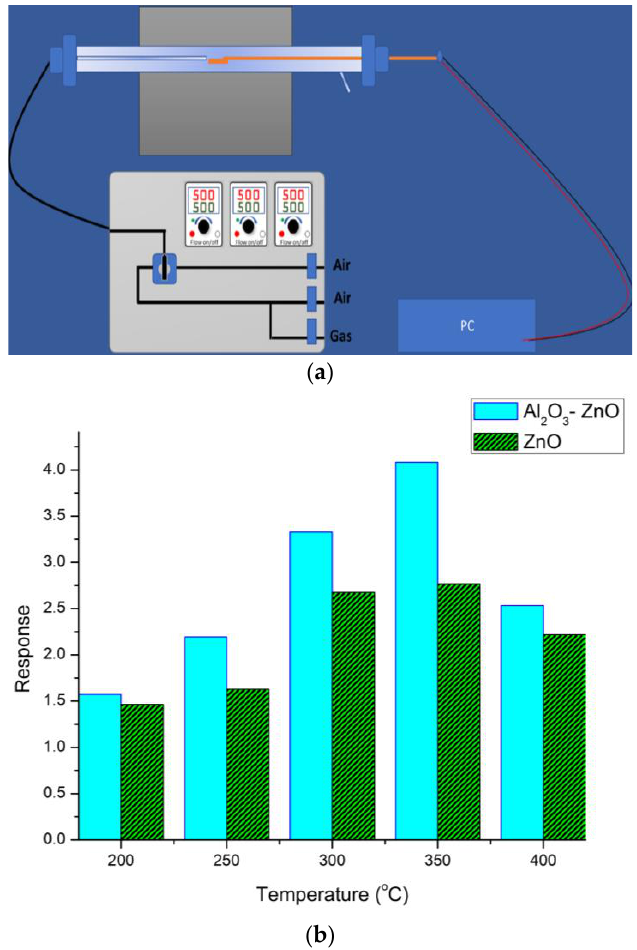
Figure 6. ( a ) Schematic diagram of the gas sensing measurement set-up. ( b ). Responses of Al 2 O 3 -ZnO nanostructures grown on Au-electrode Al 2 O 3 sensors under CO gas condition at 50 ppm. The response and recovery times, defined as the required times to reach 90% of total resistance change of the sensor, were expected to decrease when the operation temperature increased. In this study, at 350 ◦ C, both sensors showed variably fast response times (less than 8 s), whereas the recovery times were 43 s and 13 s for the undoped and Al 2 O 3 - doped sensors, respectively. It ought to be noted that the tuning of the Al concentration can give rise to different results. The gas sensing response can also be enhanced with very low concentration of Al ions, and then it decreases at higher concentrations. This latter process can affect the formation of the depletion layer [33]. The doped sample showed higher responses at higher gas concentrations, which probably occurred due to the creation of additional adsorption sites in the Al-doped sensor; however, further study is still needed to elucidate these